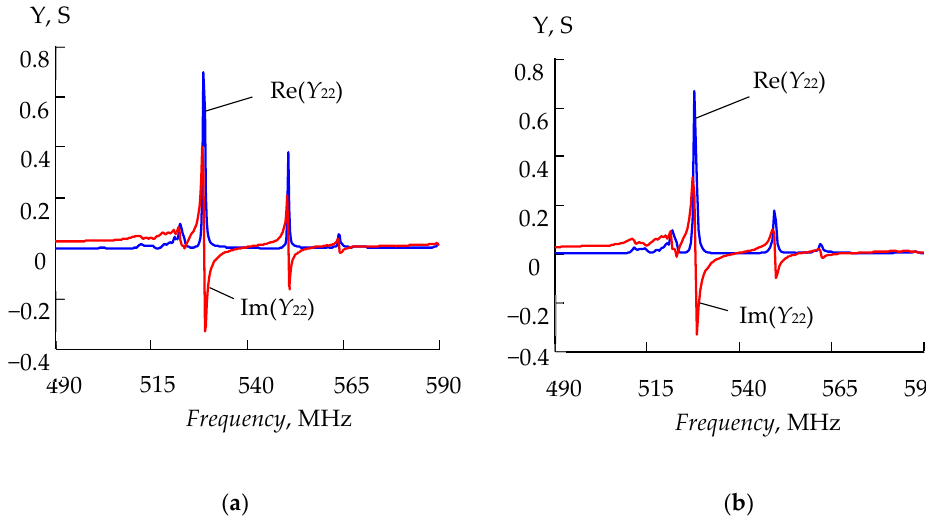
Figure 6. Admittance for one section DMS filter: ( a ) calculated by COM; ( b) calculated by FEM.